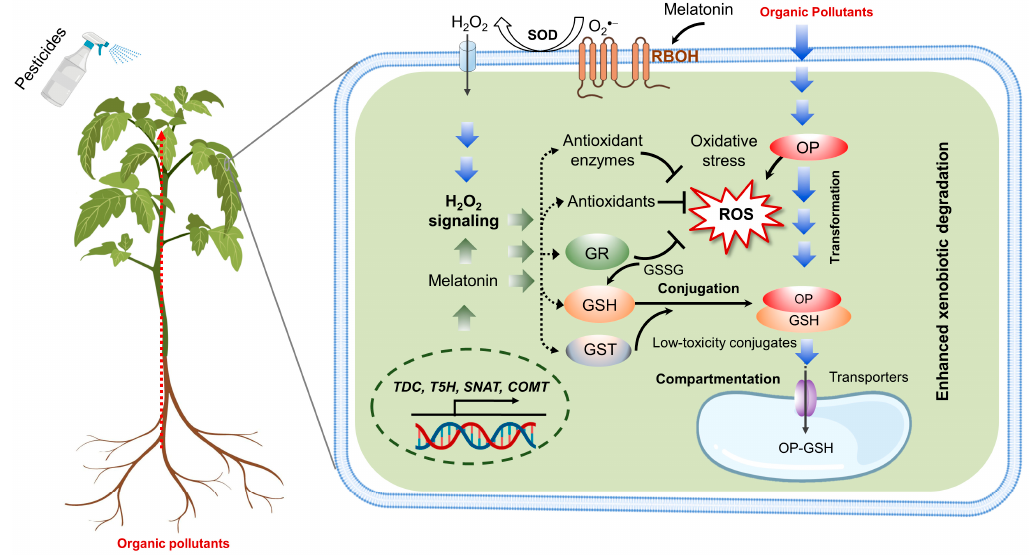
Figure 5. Mechanisms of melatonin − induced organic pollutant